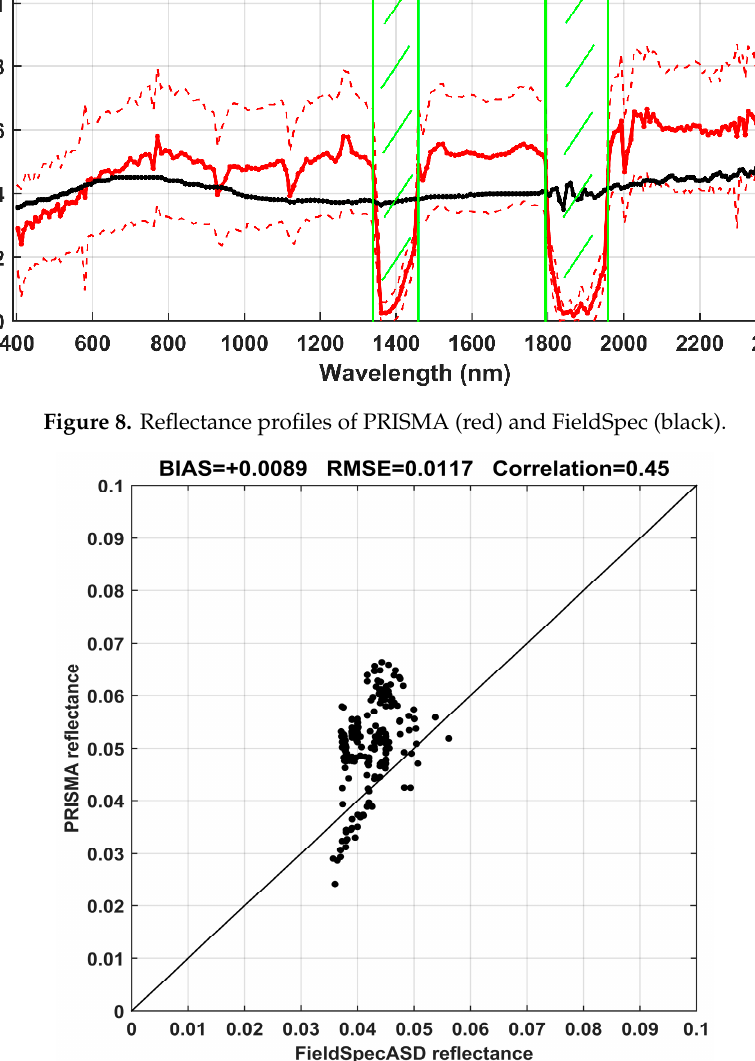
Figure 9. Scatter plot of PRISMA and FieldSpec reflectance values.